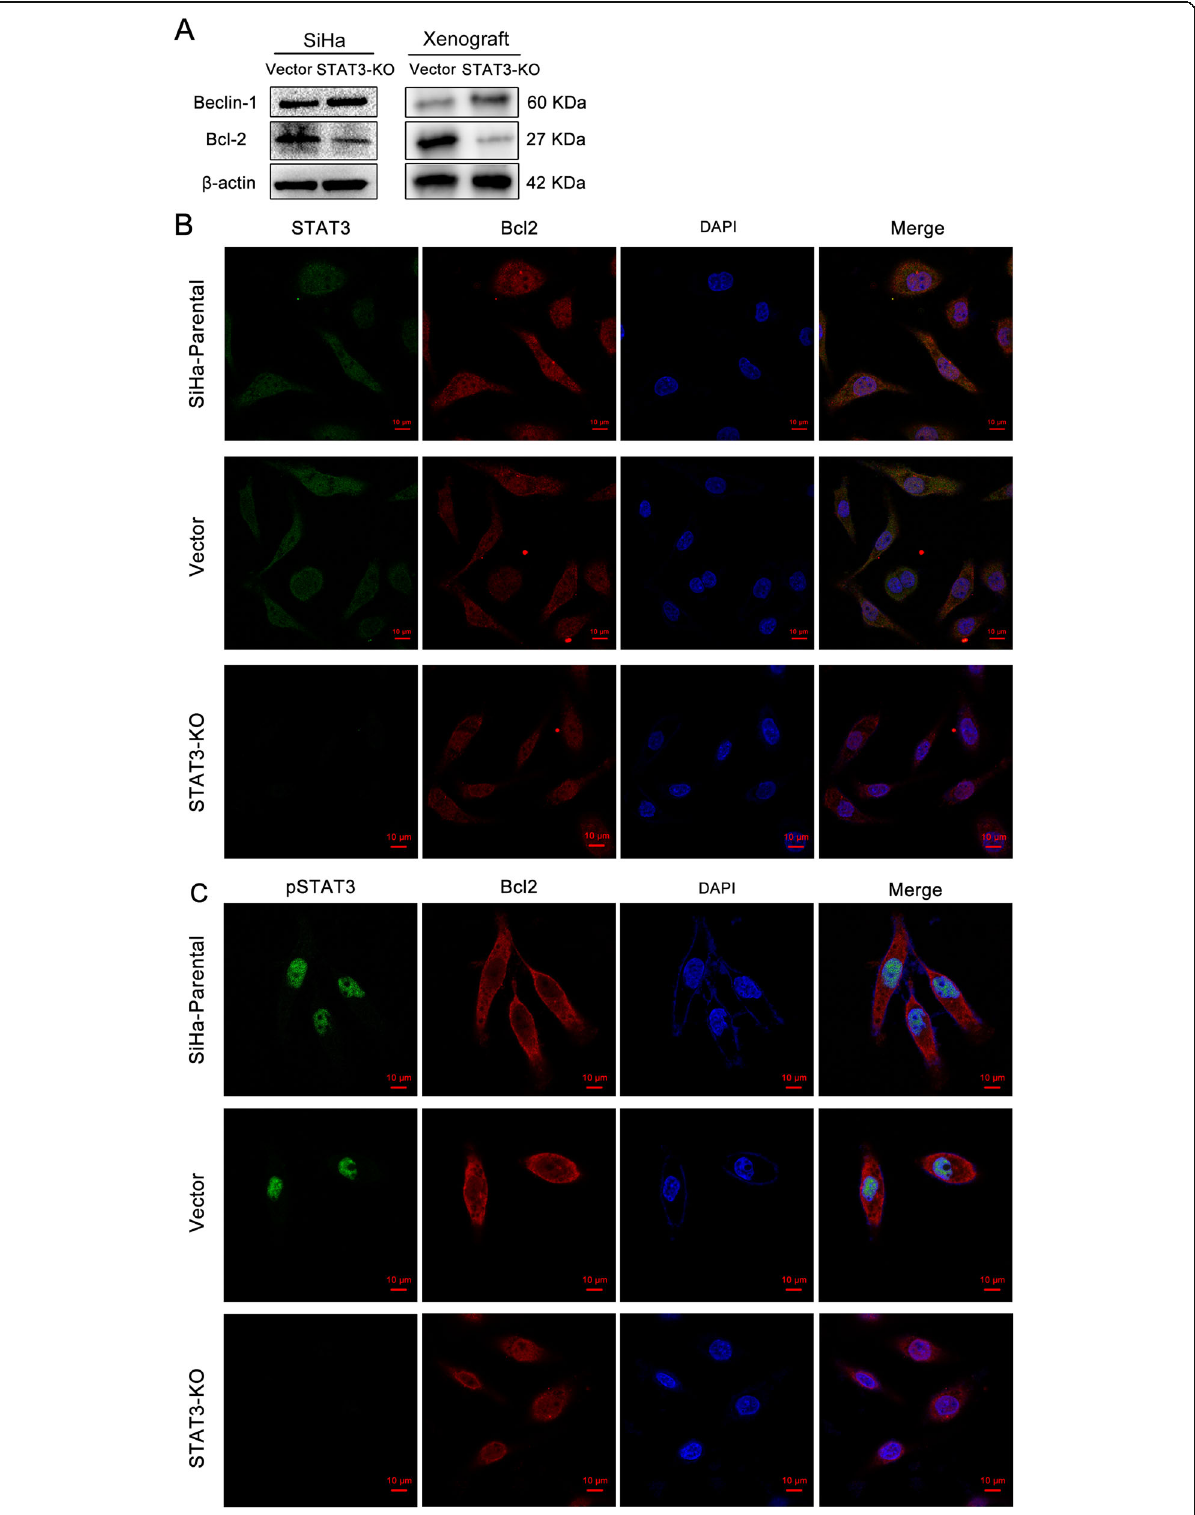
Fig. 4 STAT3 regulates autophagy of cervical cancer through bcl2-beclin1 axis. A The protein expression of Beclin1, Bcl2 in cervical cancer cells and the Xenograft; B and C . Intracellular STAT3, PSTAT3, Bcl2 protein expression sub localization of cervical